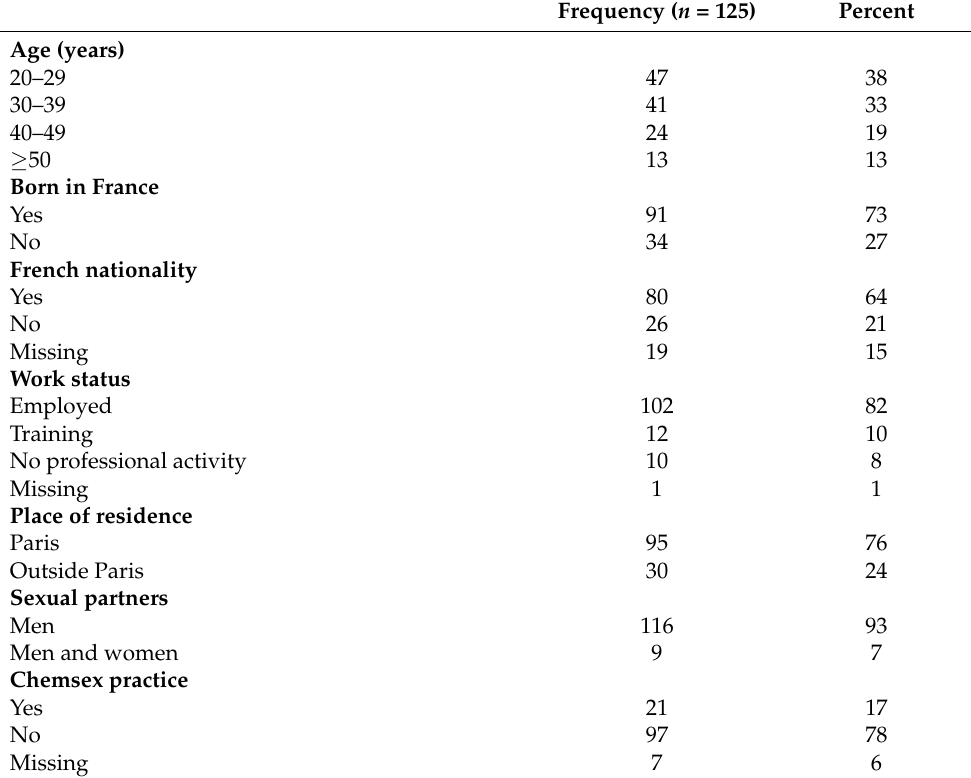
Table 1. Sociodemographic characteristics and sexual practices of patients using HIV pre-exposure prophylaxis at the first